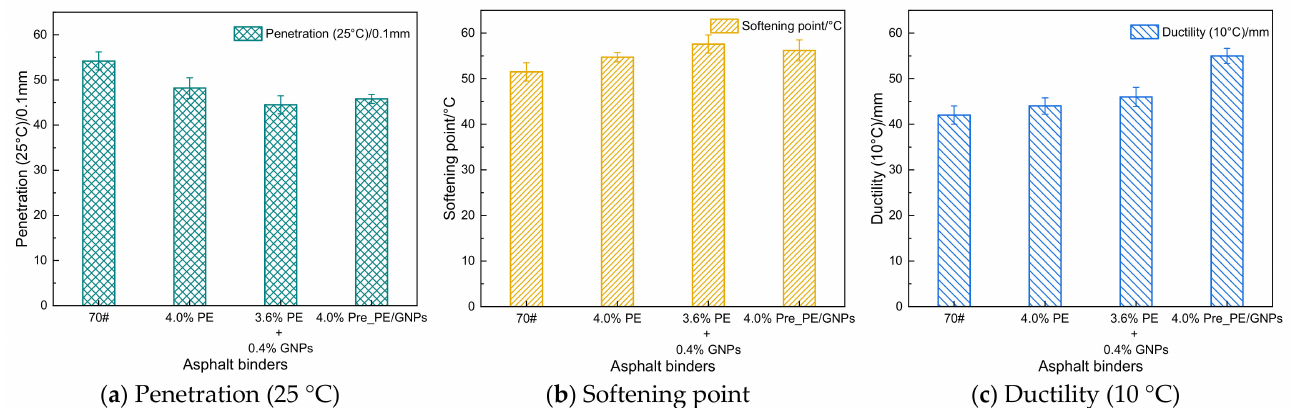
Figure 3. The physical properties of asphalt binder samples. ( a ) Penetration (25 ◦ C), ( b ) Softening point, ( c ) Ductility (10 ◦ C).